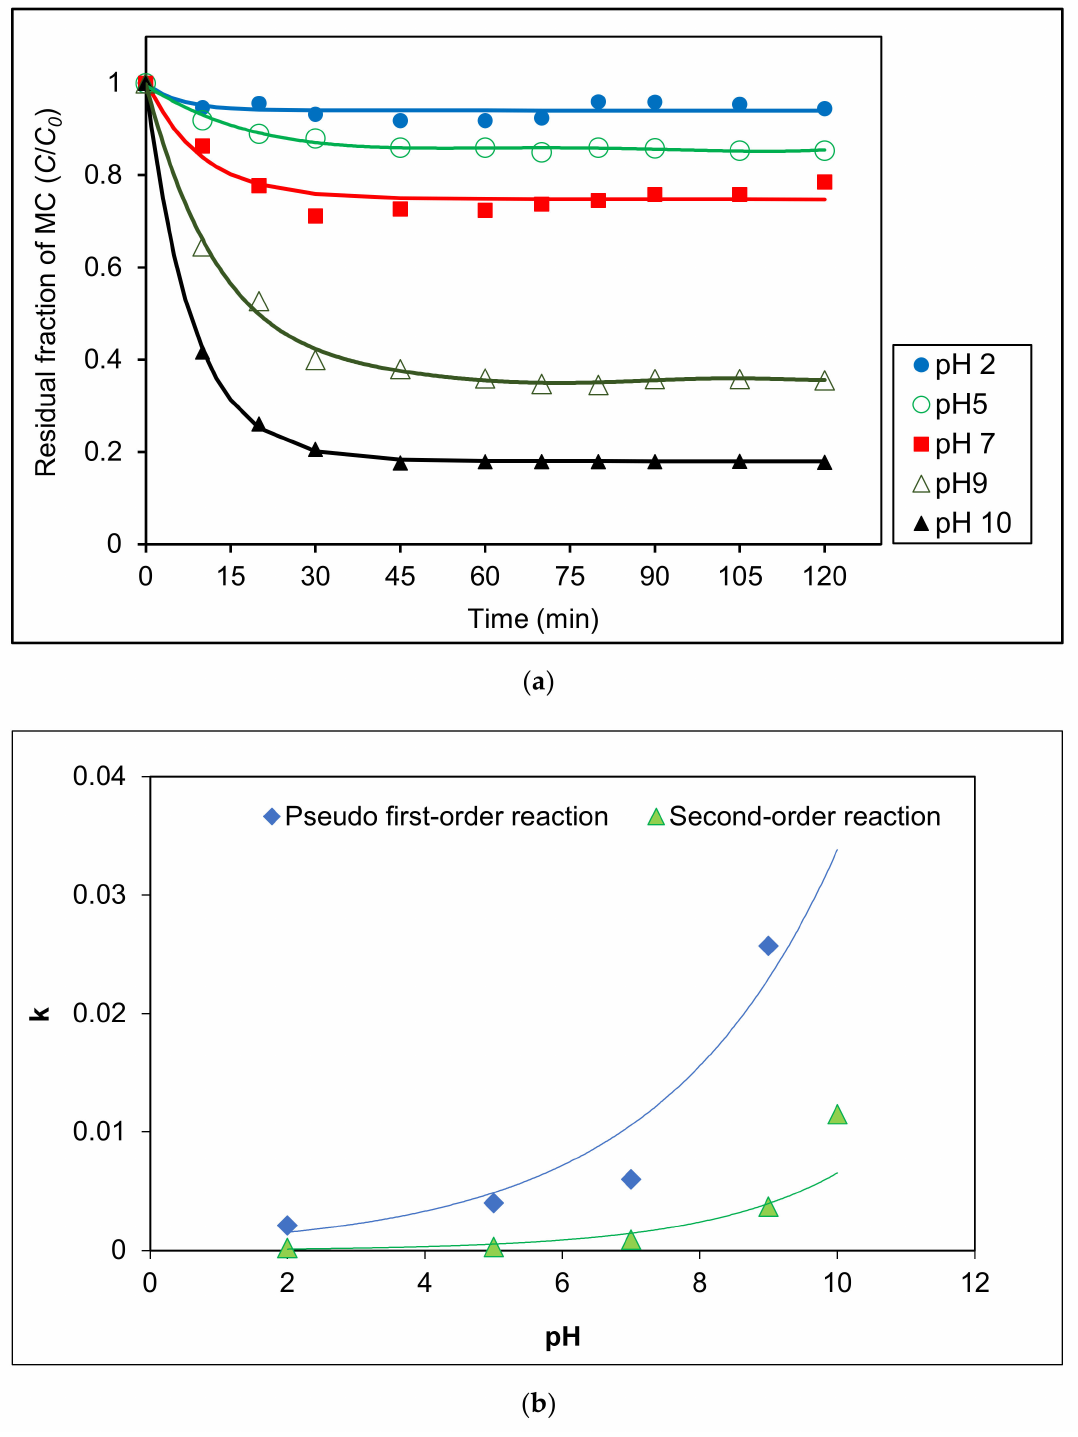
Figure 4. Effect of different pH solutions on ( a ) residual fraction of MC with time using Ag/AgCl-G and ( b ) relation of kinetic constants (k) with different pH solutions (Ag/AgCl-G loading = 0.4 g L − 1 and MC concentration = 10 mg L − 1